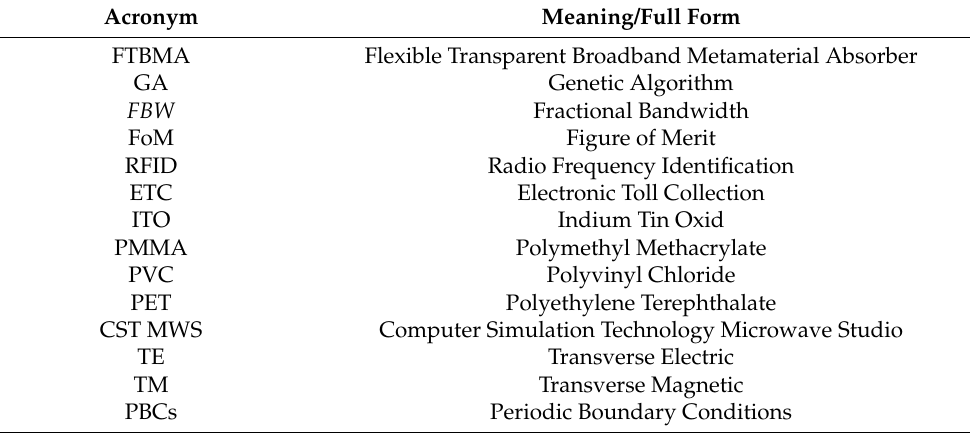
Table 2. Acronyms used in this